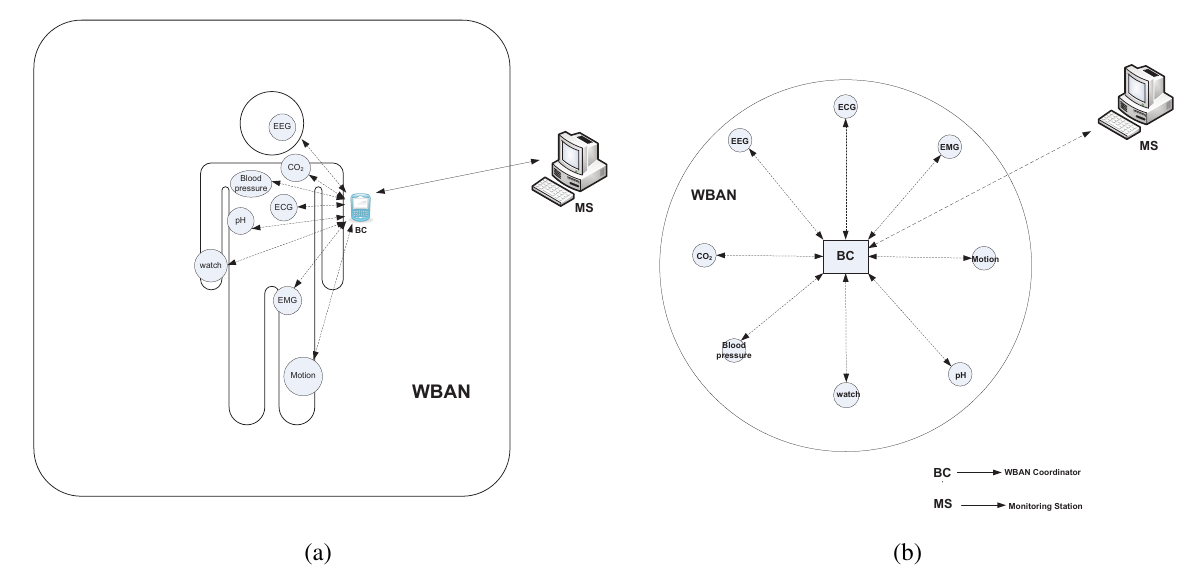
Figure 1. Network